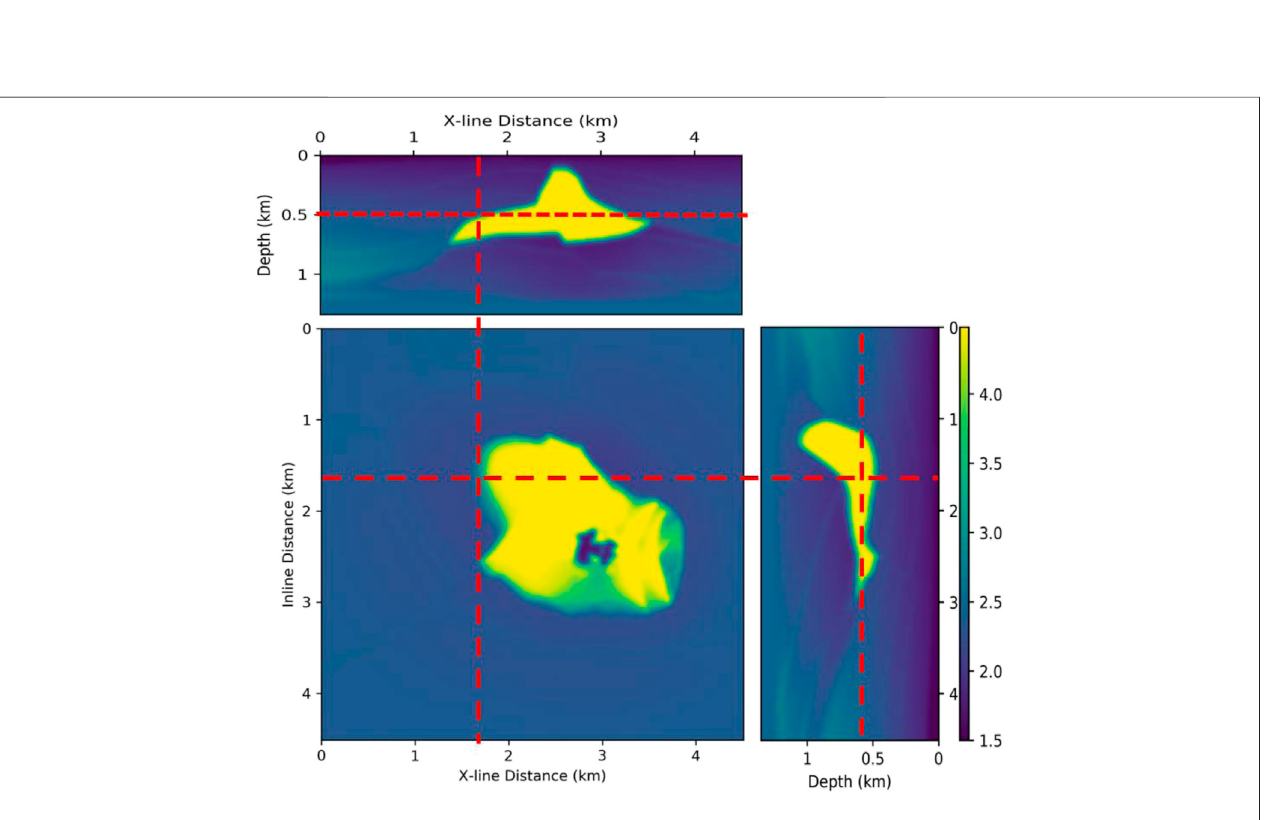
Frontiers in Earth Science |